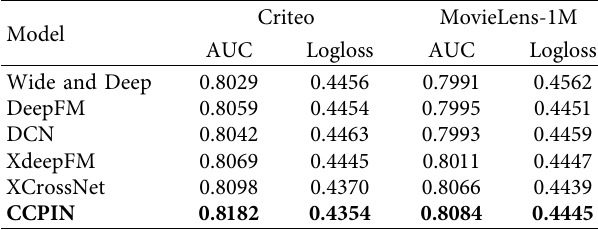
Table 1: Performance evaluation of different models on the dataset.